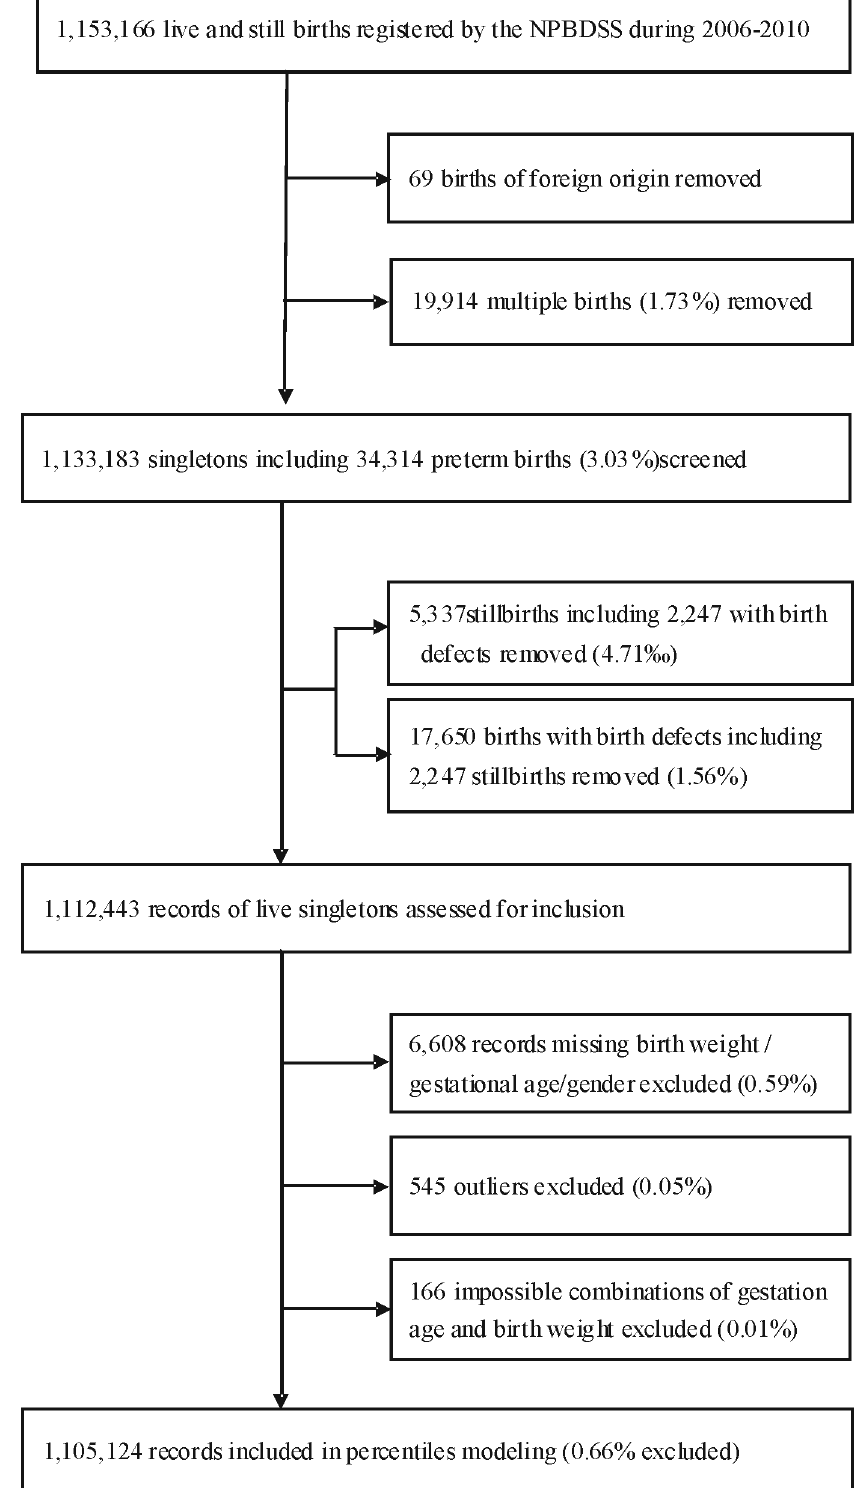
Figure 1. Flow diagram of records selection process.